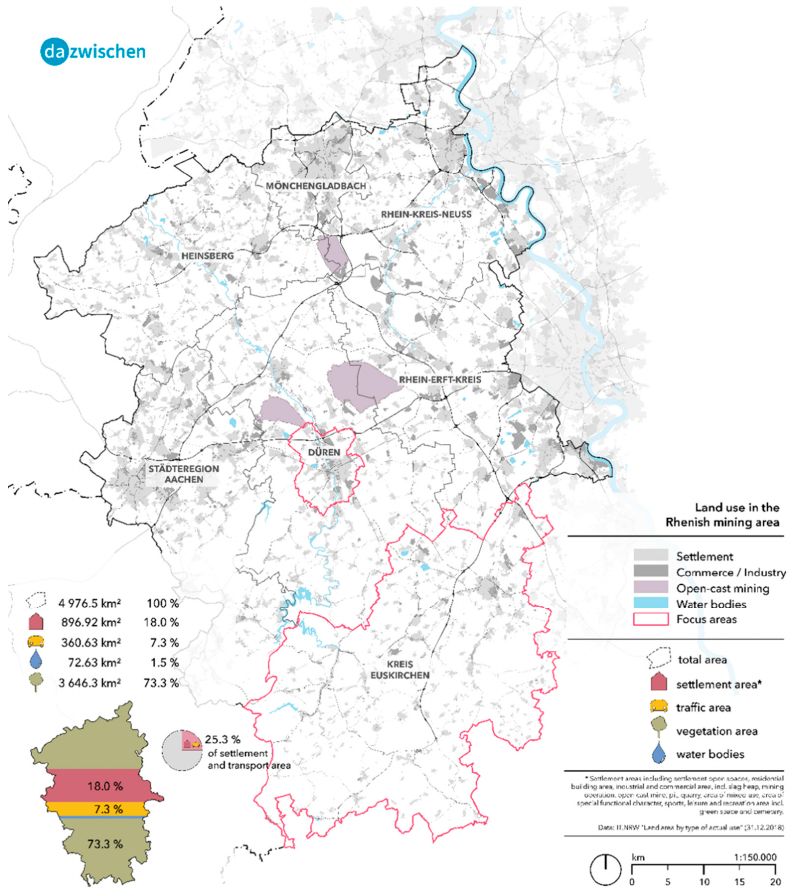
Figure 3. Land use and land distribution in the Rhenish mining area. Source: own Figure.